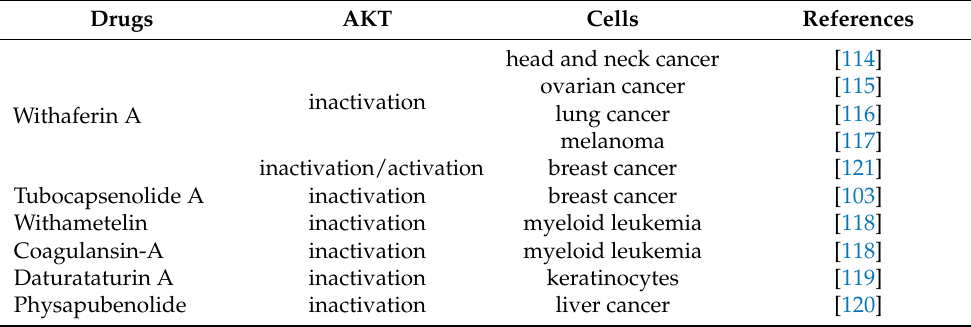
Table 3. Withanolides exhibit AKT inactivation and activation of